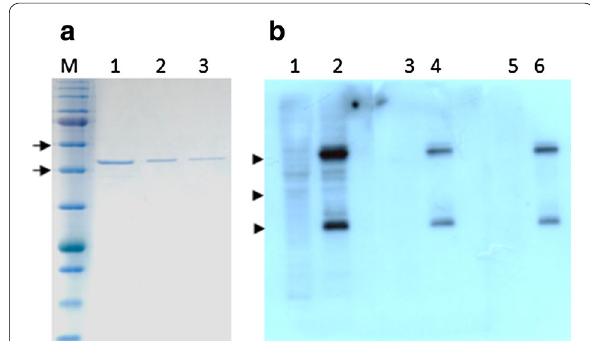
Fig. 3 Purification and reactivity of recombinant Fab fragment from clone 65. a Purification of Fab 65 from E. coli Top10F’ crude extracts after IMAC purification and subsequent affinity purification with protein L agarose beads. Samples were separated under non-reducing conditions in a 10% polyacrylamide gel stained with coomassie brilliand blue. M: prestained protein standards (NEB, P7712). Lanes 1–3: three eluates of the last purification step from the protein L agarose beads. Arrows indicate the 46 and 58 kDa molecular mass standard positions, respectively. b Western blot. Lanes 1–2: probed with a Fab 65 E. coli Top10F’ crude extract, lanes 3–4: probed with a E. coli Top10F’ Fab TT crude extract (kindly provided by the Carlos F. Barbas III laboratory, the Scripps Research Institute), lanes 5–6: probed only with the secondary antibody. Lanes 1, 3, 4: contain 20 μg NPCs lysate, lanes 2, 4, 6: contain 20 μg mouse spinal cord lysate. Arrowheads indicate the 25, 32 and 46 kDa molecular mass standard positions,